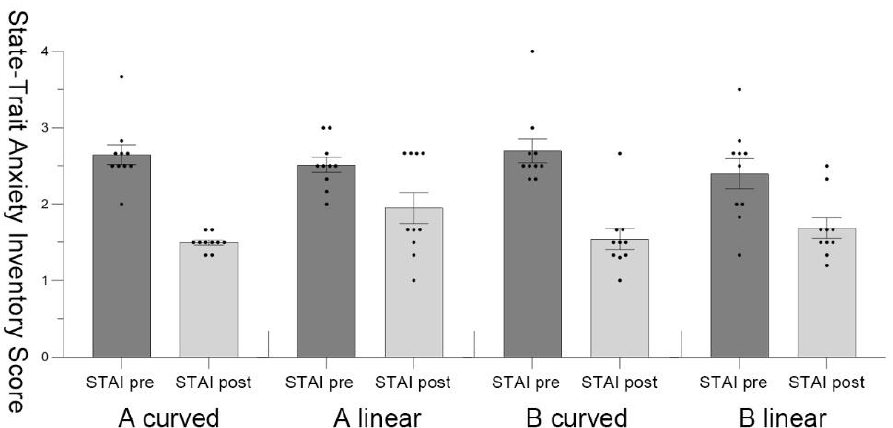
Figure 6. Pre-test and post-test of the State-Trait Anxiety Inventory (STAI) score with the standard error mean bars in scenario A and scenario B.